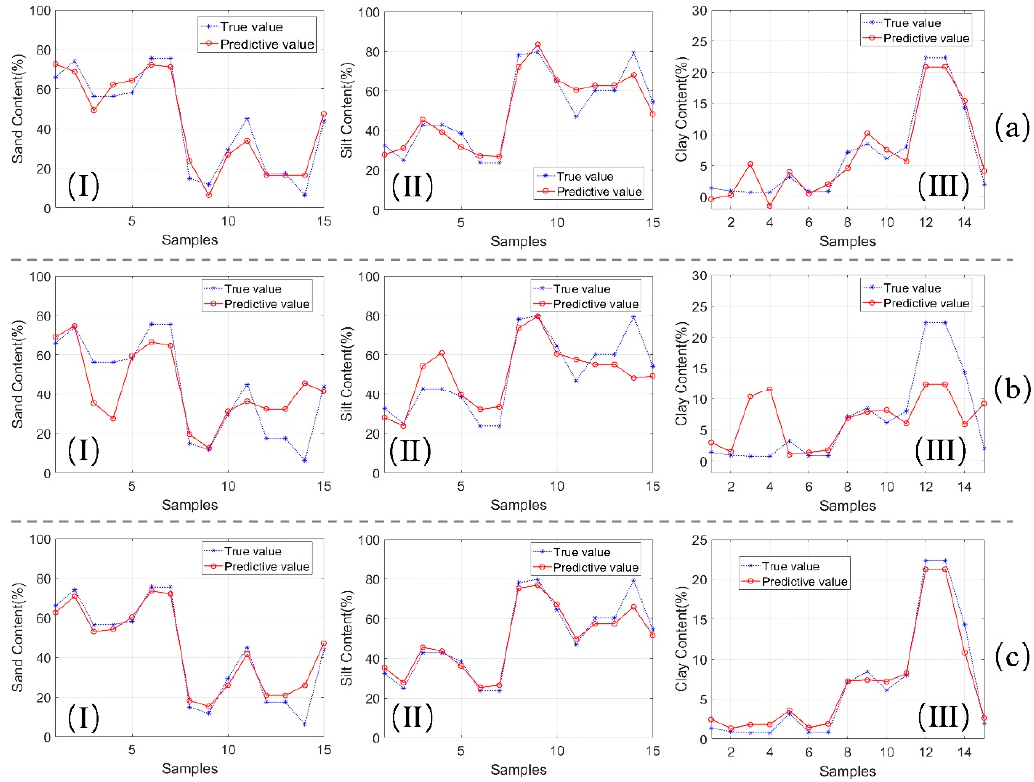
Figure 12. Fitting effect of ( a ) MLR, ( b ) PLSR, and ( c ) SVM models, (I) sand, (II) silt, and (III) clay content predicted and true values using 6SV atmospheric correction surface reflectance data.